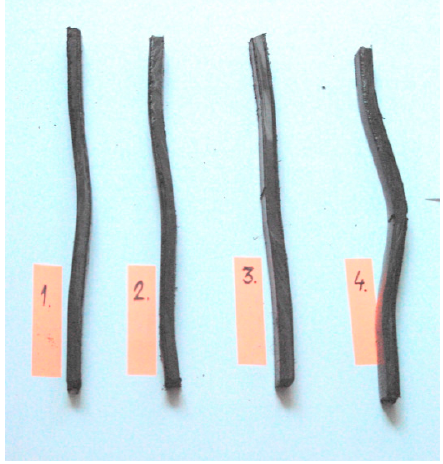
Figure 10. Compression test specimens.